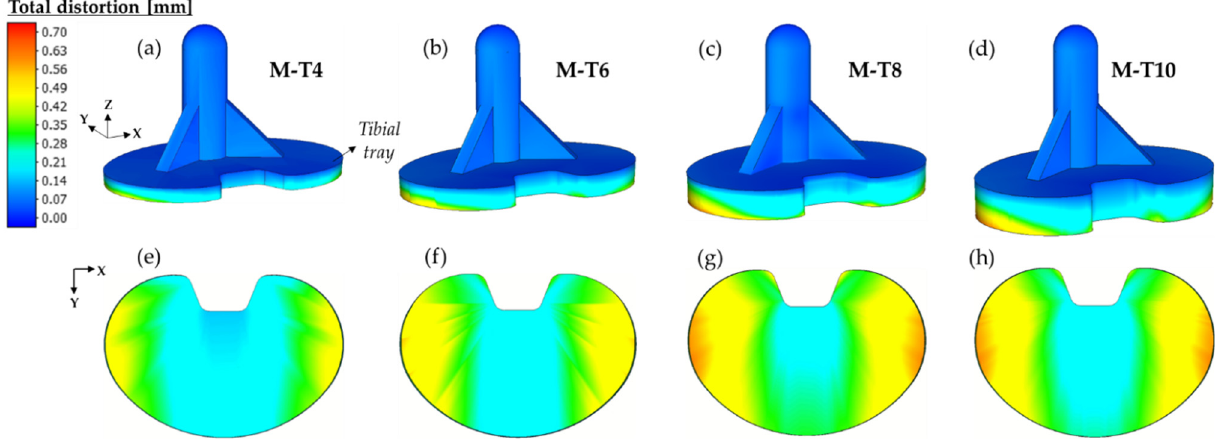
Figure 12. The total distortion at the as-built stage of medium-size tibial component with different tray thickness. ( a , e ) Medium size with 4 mm thickness (M-T4); ( b , f ) Medium size with 6 mm thickness (M-T6); ( c , g ) Medium size with 8 mm thickness (M-T8); ( d , h ) Medium size with 10 mm thickness (M-T10).